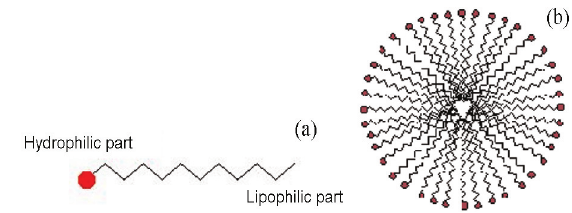
Fig. 7. Evolution of friction stress and friction coefficient as a function of time for C28 without a release